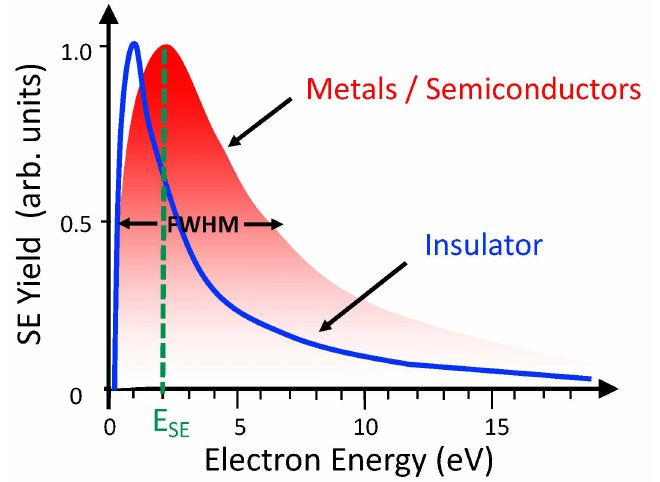
Figure 3. Schematic of energy distribution of secondary electrons (SEs) from metal and insulator surfaces. (Adapted from [59] with